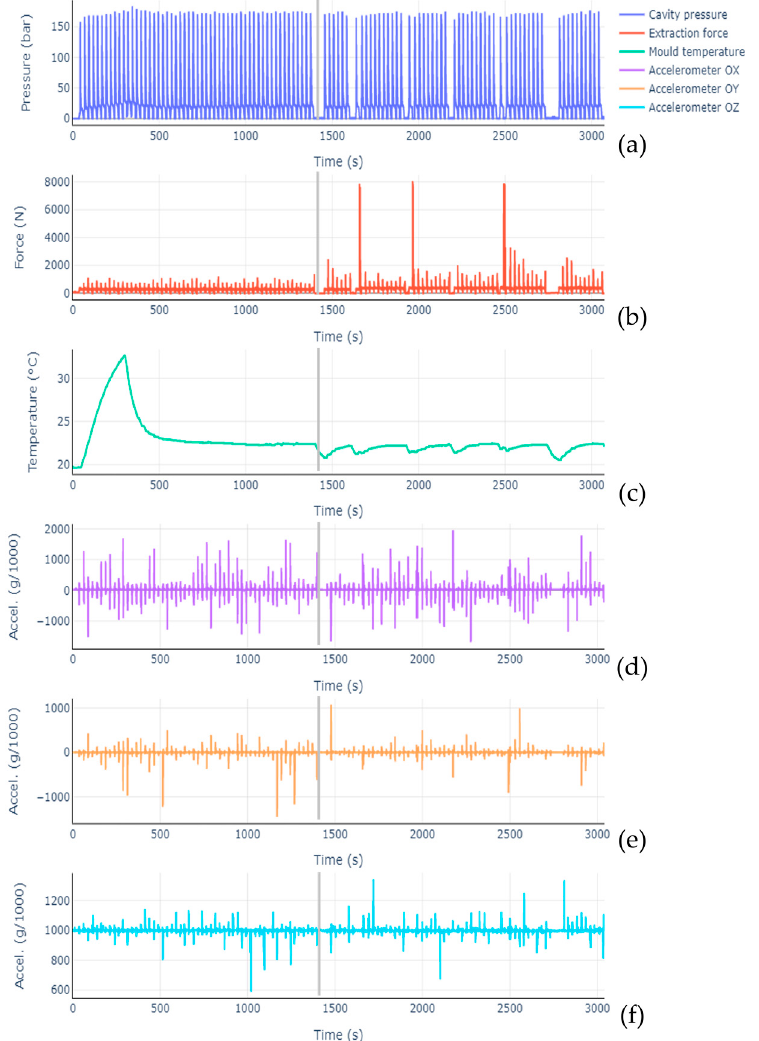
Figure 10. Graphs corresponding to the data collected both under normal operation conditions and with successive simulated faults in one of the extraction pins. ( a )—Pressure sensor, ( b )—Force sensor, ( c )—Temperature sensor, ( d )—Accelerometer (OX axis), ( e )—Accelerometer (OY axis), ( f )—Accelerometer (OZ axis).